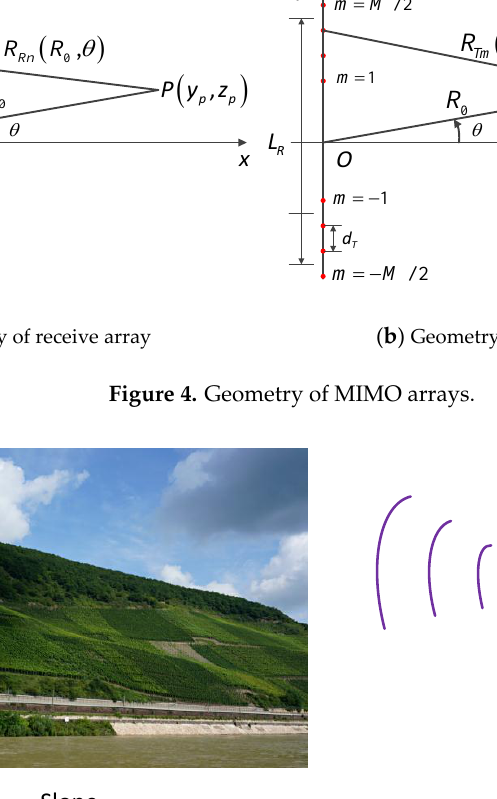
Figure 5. The geometry of slope monitoring.